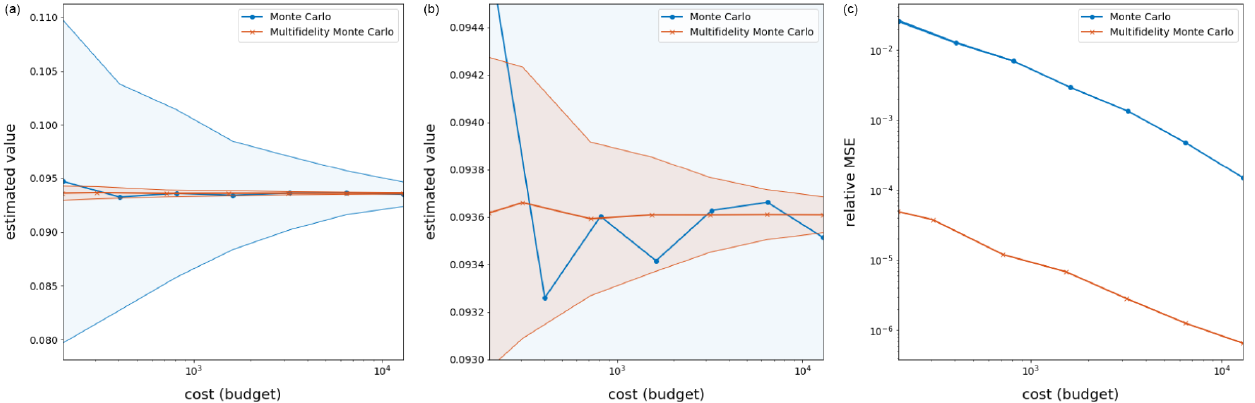
Figure 3. Results for the wind-driven barotropic gyre test with output of interest (Eq. 13) averaged over 250 applications of MC and MFMC estimation. (a) The quantity of interest Q as a function of the budget for the MC and MFMC estimators. (b) A zoom-in of the top figure. (c) The relative MSE of the MC and MFMC estimators as a function of the budget; shaded regions represent the standard deviations of the MC and MFMC predictions when compared to their averages over the 250 runs. Note that the melon region is contained in the blue region, indicating that the MFMC estimator has a smaller standard deviation than the MC estimator.